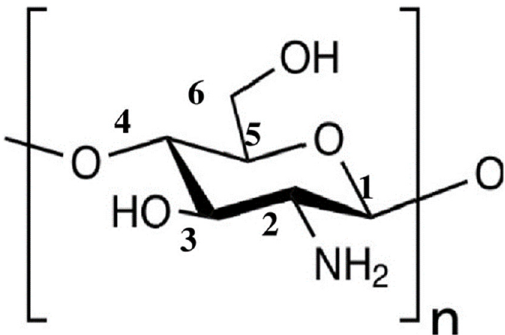
Figure 1. Chemical structure of chitosan.